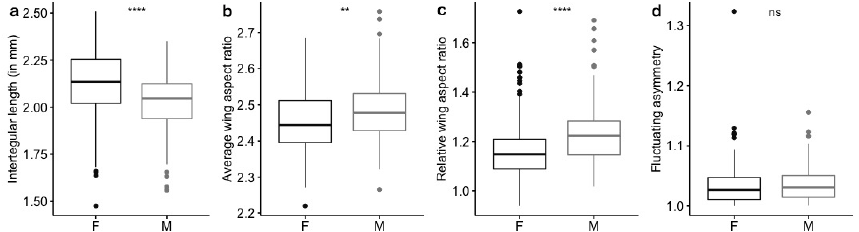
Figure 3. Differences between female (left) and male (right) in ( a ) intertegular length, ( b ) average wing aspect ratio, ( c ) relative wing aspect ratio, and ( d ) fluctuating asymmetry. Two sample t -test, ns: p > 0.05, **: p < 0.01, ****: p < 0.0001. Intertegular length is significantly positively related to wing length ( β = 0.332, Std. Error = 0.012, t = 28.68, p < 0.0001) and wing area ( β = 0.106, Std. Error = 0.004, t = 26.78, p < 0.0001).